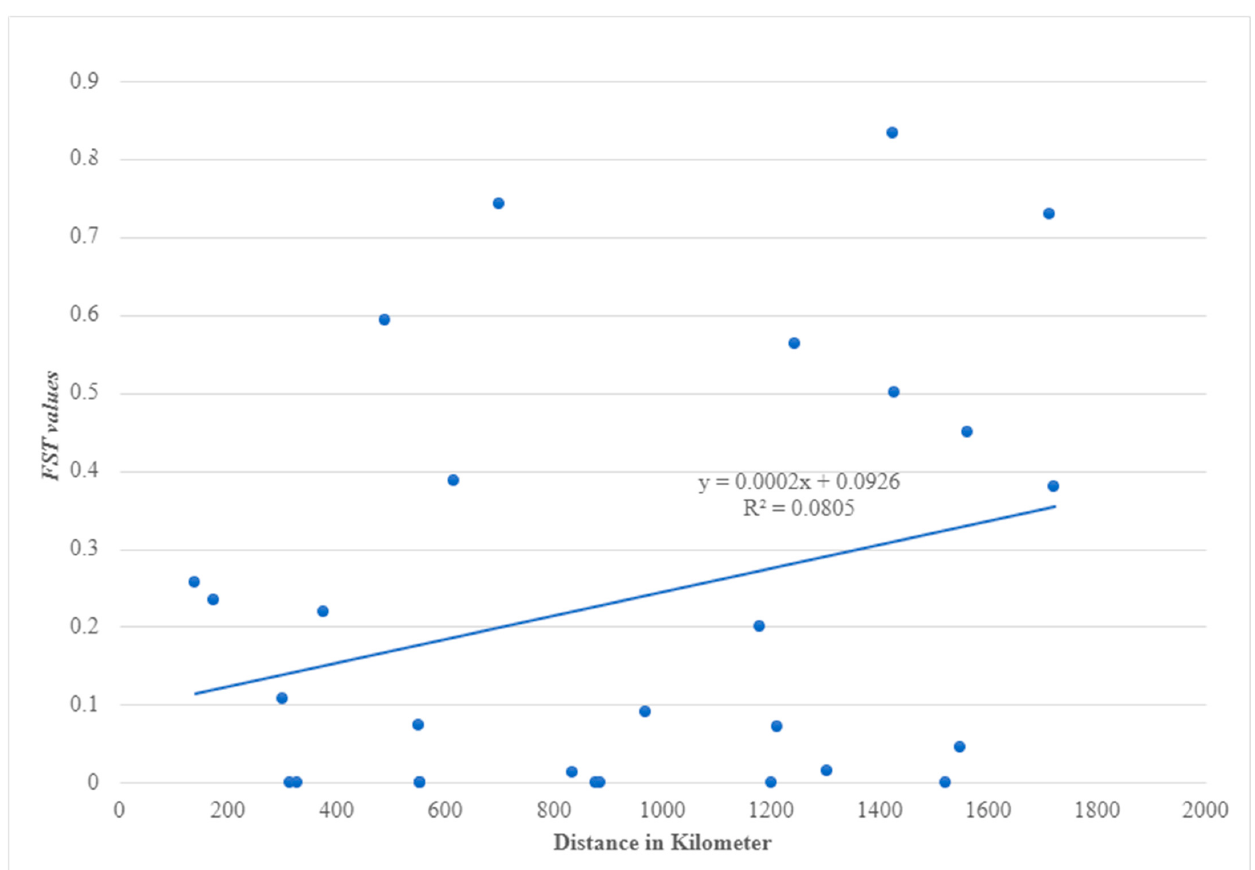
Figure 3. Correlation between genetic ( F ST ) of NADH dehydrogenase subunit 4 ( ND4 ) mitochondrial gene and geographical distance (km) of Aedes aegypti samples from Sudan . gene and geographical distance (km) of Aedes aegypti samples from Sudan.